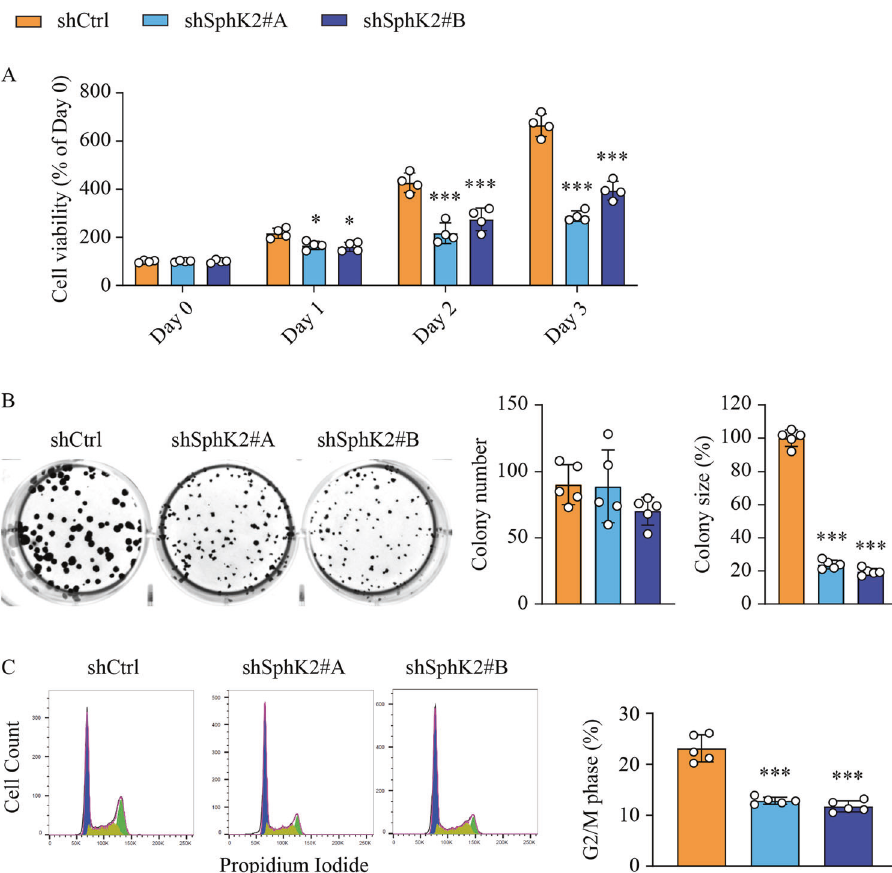
Fig. 3 The anti-cancer properties of SphK2 de fi ciency in FFA-treated hepatic cells. Huh7 hepatic cells were transduced with lentiviral-based short hairpin RNA (shRNA) to knock down SphK2 and then treated with a combination of free fatty acids (FFA, 200 µM palmitate + 400 µM oleate). A Cell viability was determined by MTS assay in cells treated with FFA for the indicated times; n = 4. B Colony formation assay was performed over ten days of cell culture in the presence of FFA. The number and size of colonies were quanti fi ed; n = 5. C Cell cycle phases were examined in cells treated with FFA for 24 h, using fl ow cytometry with propidium iodide staining. G 0 /G 1 , S, and G 2 /M phase populations were estimated using FlowJo software and are indicated in blue, yellow and green in histograms, respectively. The percentage of the G 2 /M phase, indicative of cell cycle progression, was analyzed, n = 5. Data are expressed as mean ± SD. * p < 0.05; *** p < 0.001; versus